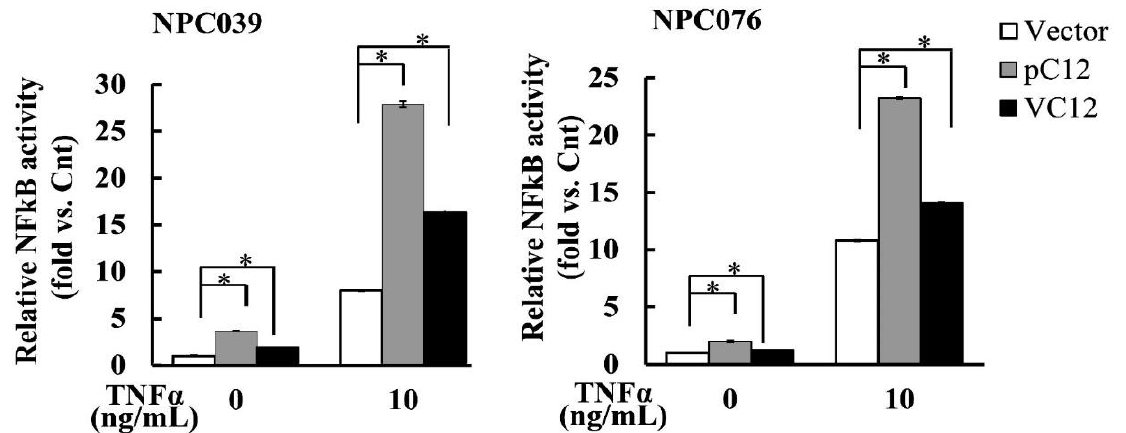
Figure 7. The Casp12-mediated NF- κ B activity enhanced by TNF α stimuli. NPC cells were transfected with pC12/VC12 plasmid, NF- κ B reporter/pSV- β -galactosidase plasmids for 18 h. The transfected cells were treated with TNF- α (10 ng/mL) for 6 h and the cell lysates were used to detect the luciferase activity. Transfection with an empty vector (pEGFP-N3) plasmid (0.5 µ g/mL) was as a control group cells. Luciferase activity is presented relative to the control group. The data from three independent experiments are graphed as the mean ± s.e.m. ( n = 3). * p < 0.05.